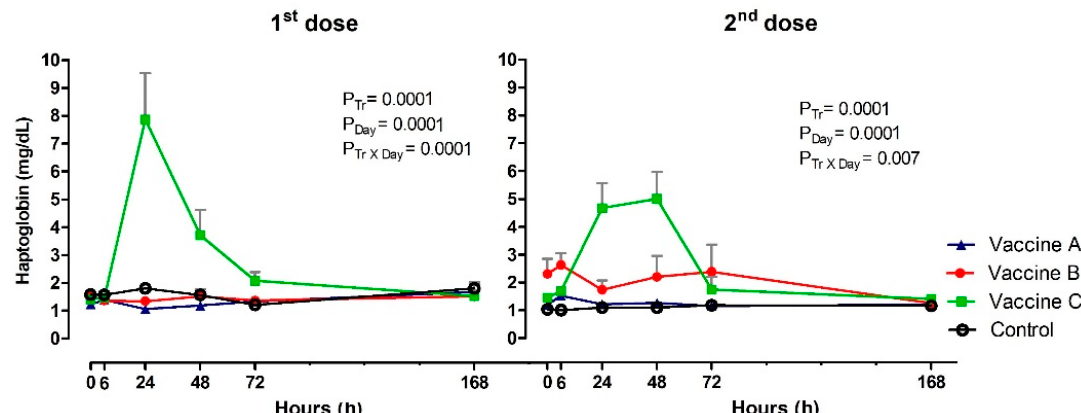
Figure 6. Acute phase protein production from haptoglobin concentrations (mg / dL) in animals vaccinated with three different formulation adjuvanted vaccines against BVDV and BHV-1. Reported are the mean values and standard deviations. Overall statistical significance ( p ≤ 0.05) is indicated in the plot as follows: Effects of treatment (P tr ), day (P Day ) and interactions (P tr x P Day ).